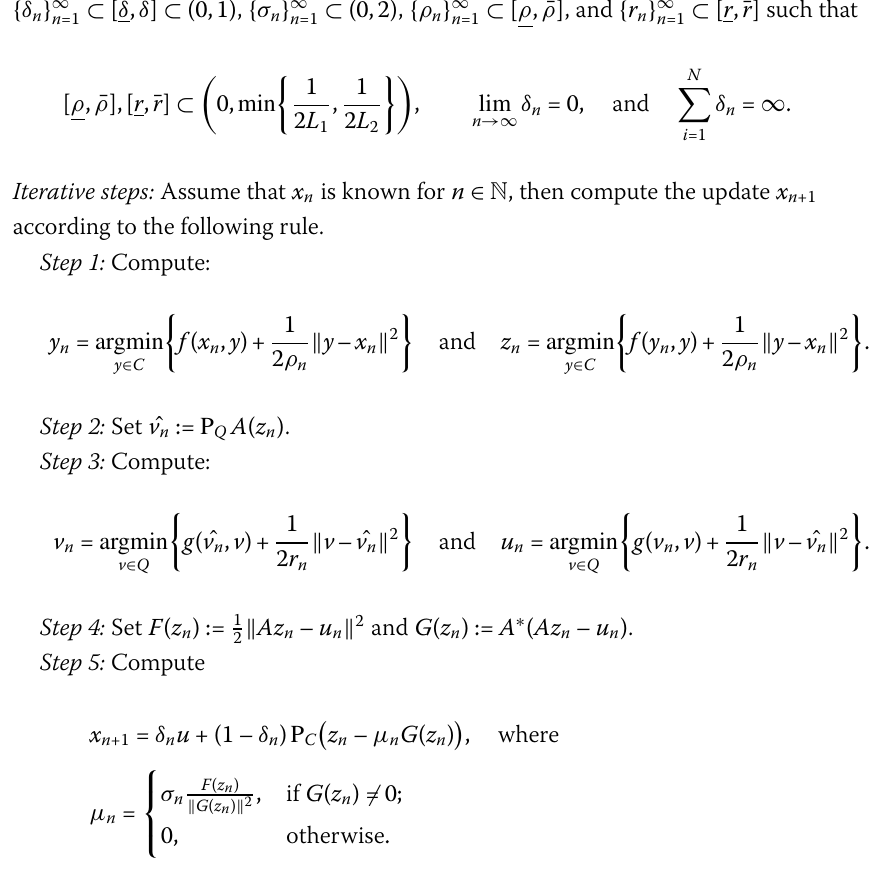
Algorithm 3.1 (Self-adaptive proximal-extragradient algorithm for